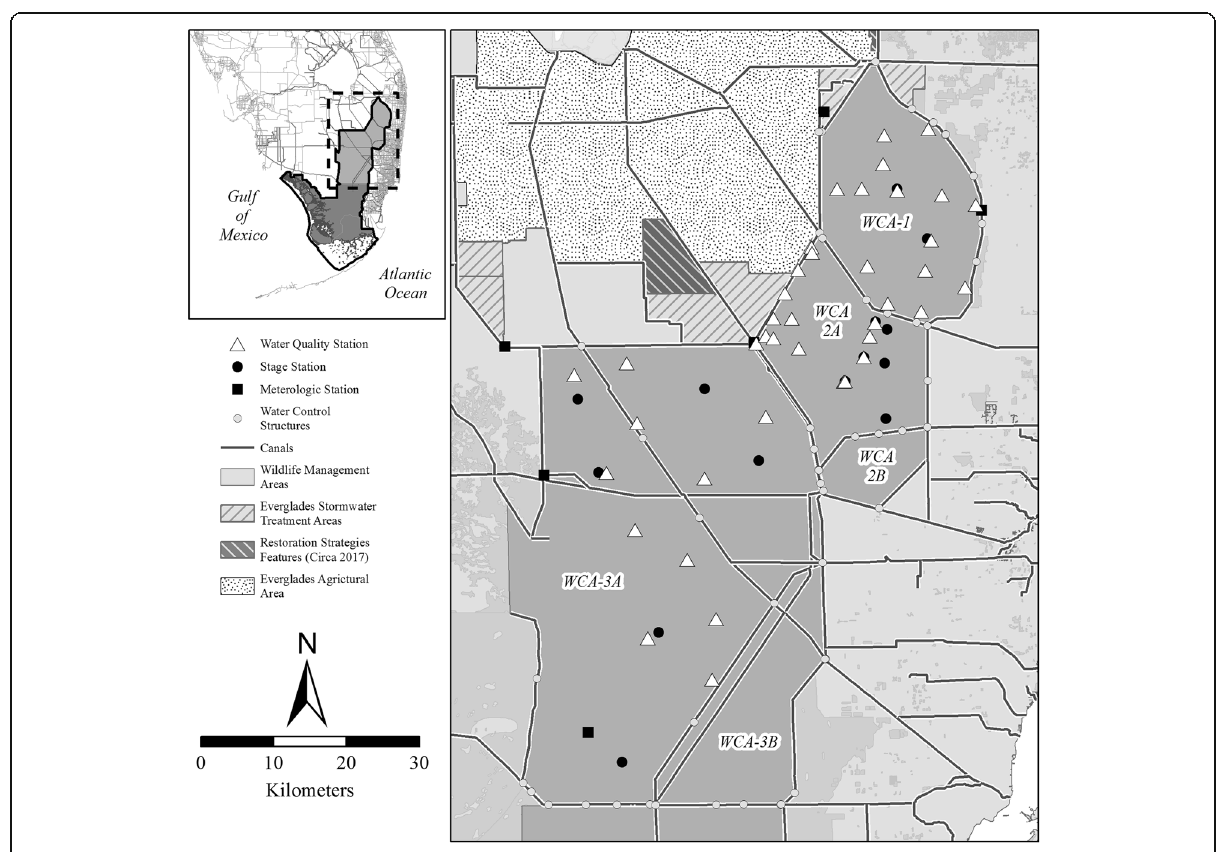
Fig. 1 Map of surface water quality, stage, and weather monitoring location within the Everglades Protection Area relative to surrounding features including the Everglades Stormwater Treatment Area, Everglades Agricultural Area, and Water Conservation